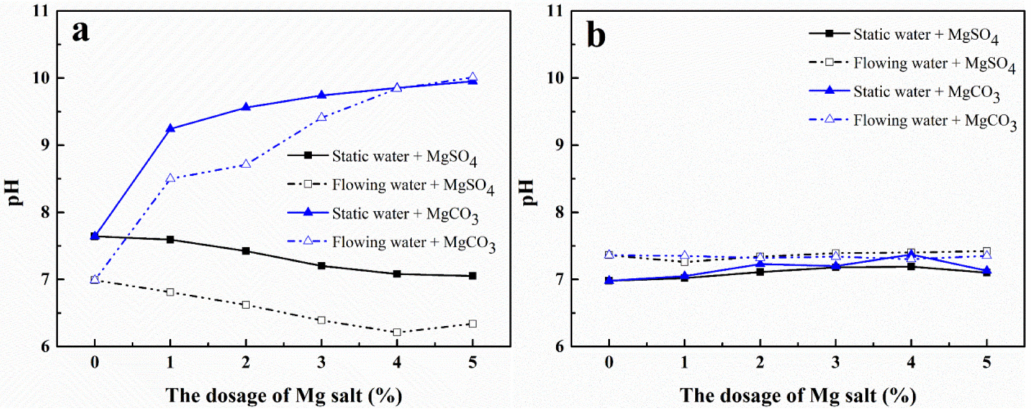
Figure 2. The relationship between the pH value of magnetized distilled water ( a ) and magnetized calcium chloride sodium bicarbonate solution ( b ) with magnesium salt concentration under di ff erent water flow